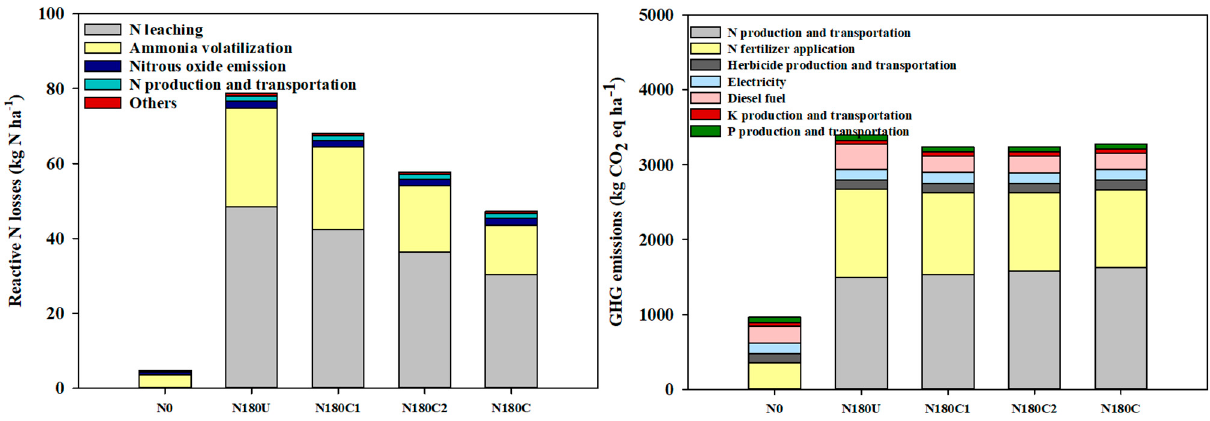
Figure 4. The Nr losses and GHG emissions across the 2019 and 2020 growing periods in the summer maize life cycle. N0, no N; 180, 180 kg N ha − 1 ; U, solely urea; C1, ratio of controlled-release nitrogen to urea nitrogen is 1:2; C2, ratio of controlled release nitrogen to urea nitrogen is 2:1; C, all CRU.